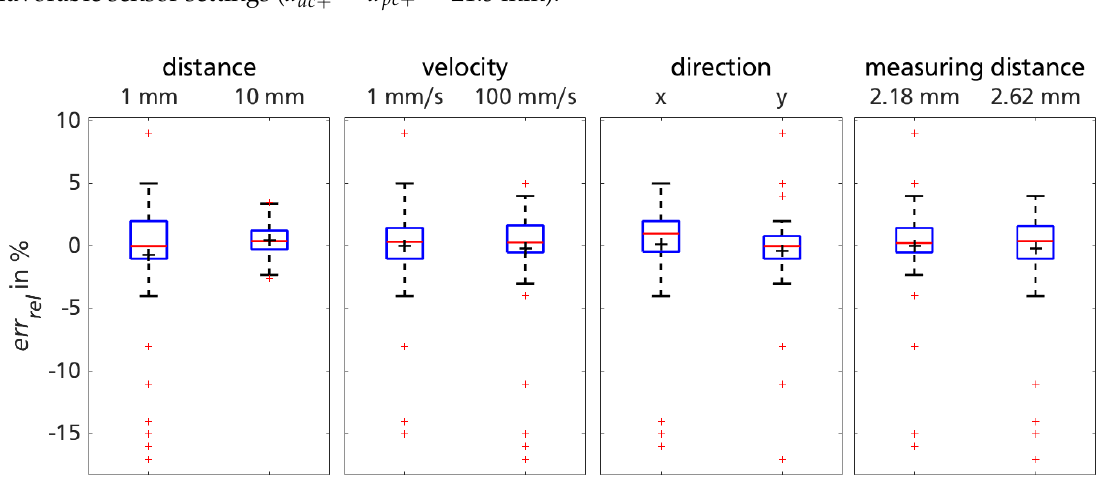
Figure 7. Sensor performance with favorable settings regarding cavity diameter dimension, grouped for remaining measurement factors of trial session